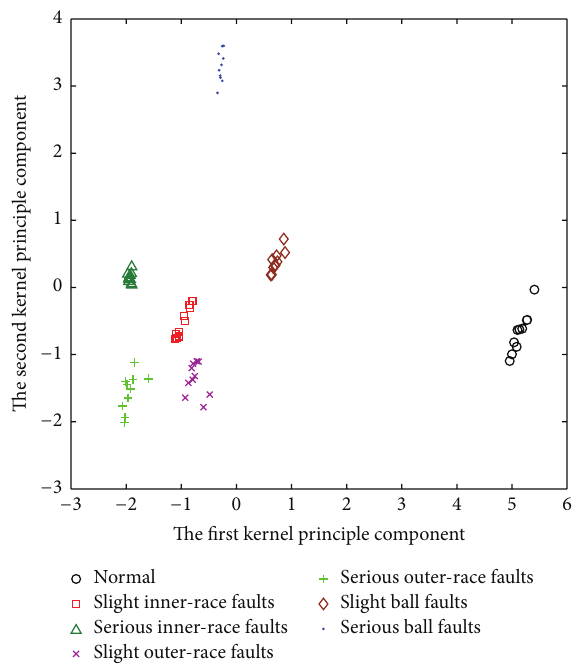
Figure 8: The result of classification of seven vibration signals.